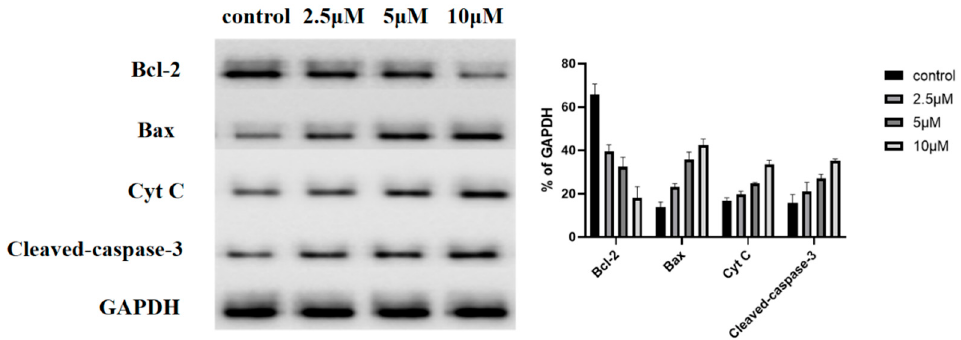
Figure 5. Effects of hybrid A8 on the expression of related proteins of MCF-7 cells. Cells were treated with 0, 2.5, 5 and 10 μ M of compound A8 for 48 h, and GAPDH was used as the internal